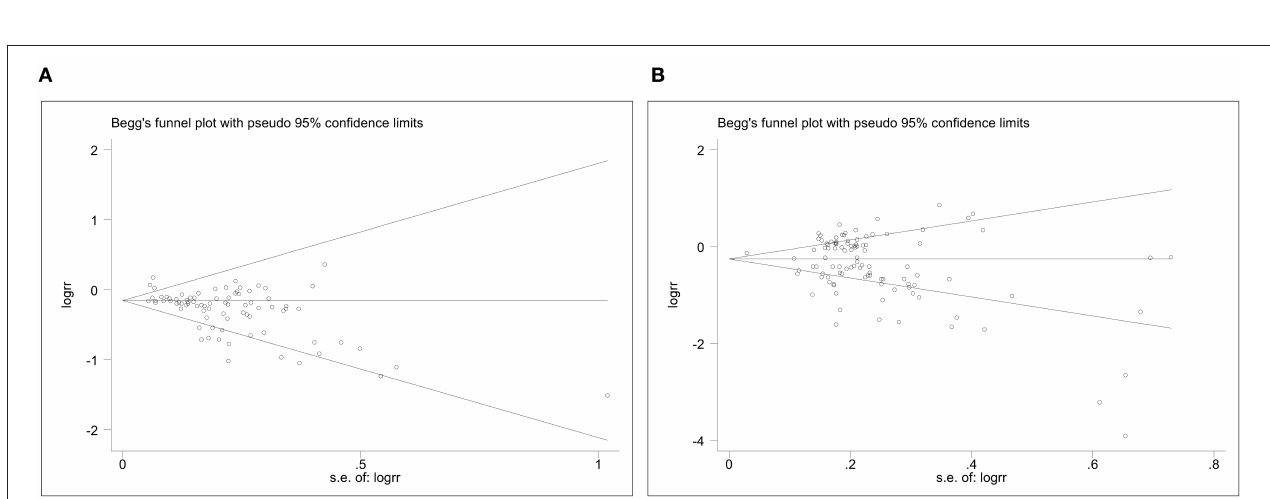
FIGURE 3 | The Begg’s funnel plots for plant-based diets and cancer risk. (A) , Plant-based diets and cancer risk in cohort studies. (B) , Plant-based diets and cancer risk in case-control studies.